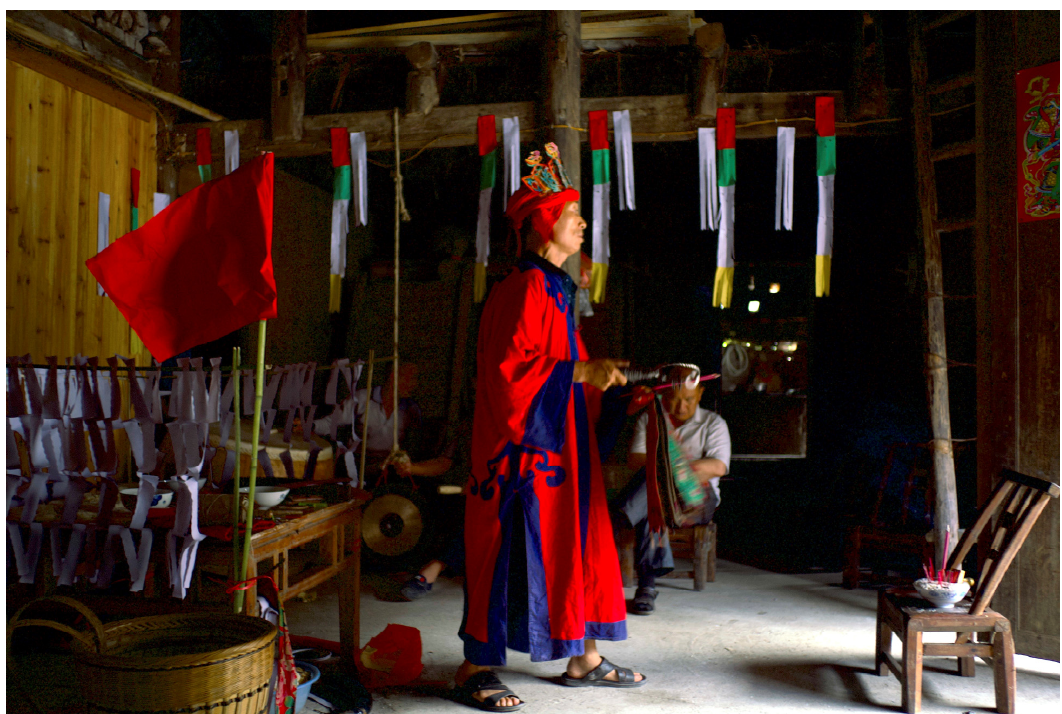
Figure 4. Badai Yang inviting in the spirits and armies. He dances the hexagon in front of the left altar. (Photo: Thomas Riccio).